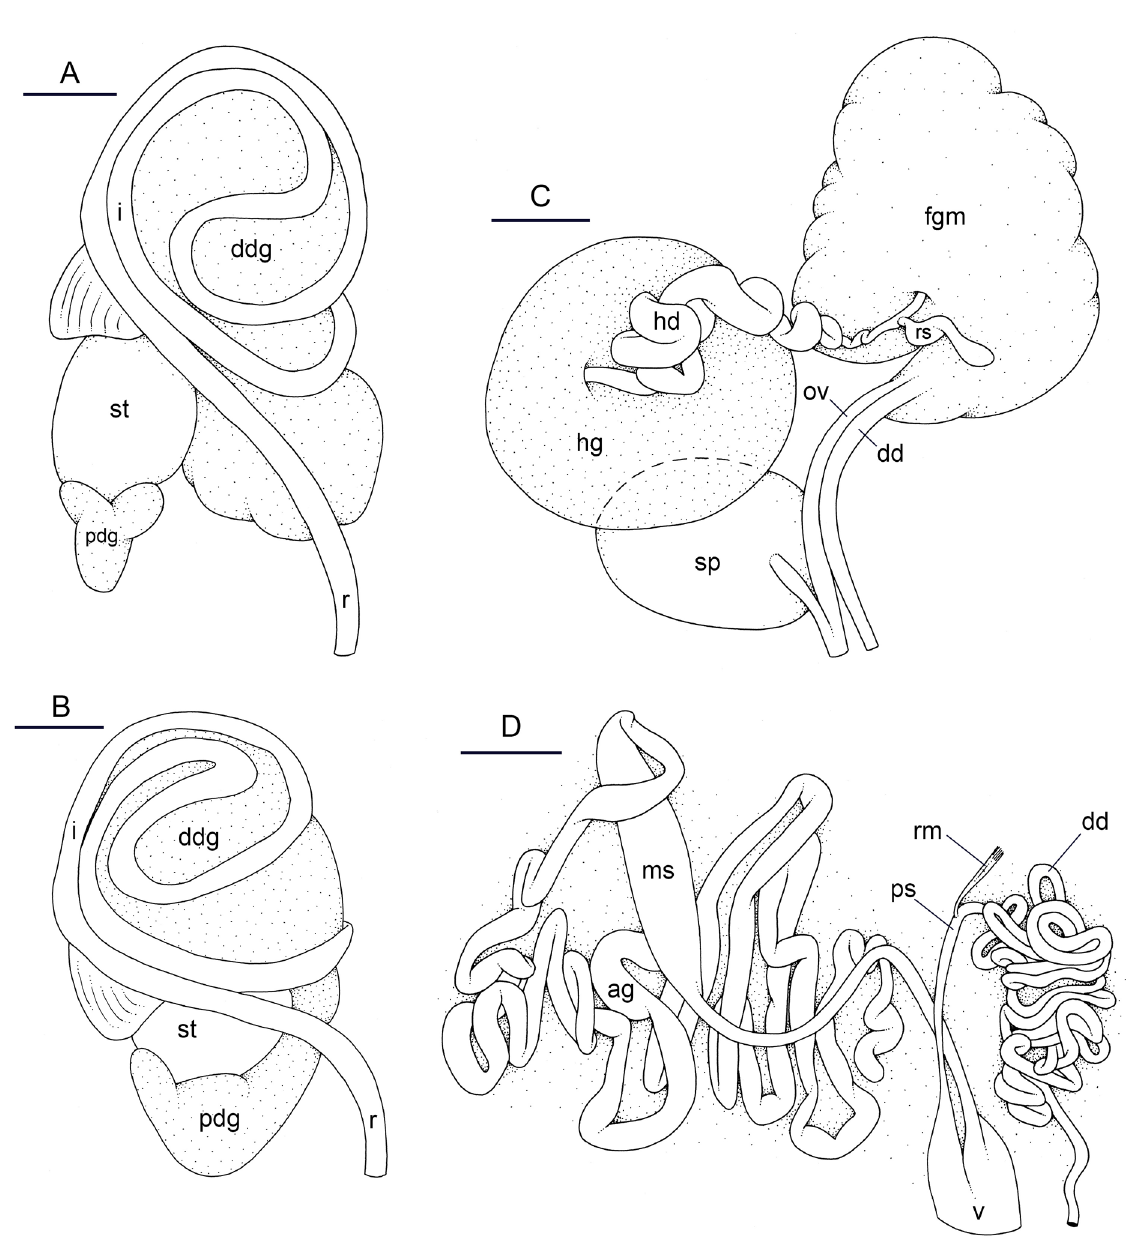
Fig. 27. Paromoionchis daemelii (Semper, 1880) comb. nov. A . Digestive system, Australia, New South Wales [1519] (AM C.468917.001). B . Digestive system, lectotype of Onchidium daemelii (ZMB 31640a). C . Posterior hermaphroditic (female) reproductive system, same as A. D . Male copulatory organs, same as A. Abbreviations: ag = accessory penial gland; dd = deferent duct; ddg = dorsal lobe of digestive gland; fgm = female gland mass; hd = hermaphroditic duct; hg = hermaphroditic gland; i = intestine; ms = muscular sac (of accessory penial gland); ov = oviduct; pdg = posterior lobe of digestive gland; ps = penial sheath; r = rectum; rm = retractor muscle; rs = receptaculum seminis; sp = spermatheca; st = stomach; v = vestibule. Scales: A = 4 mm; B–D = 3